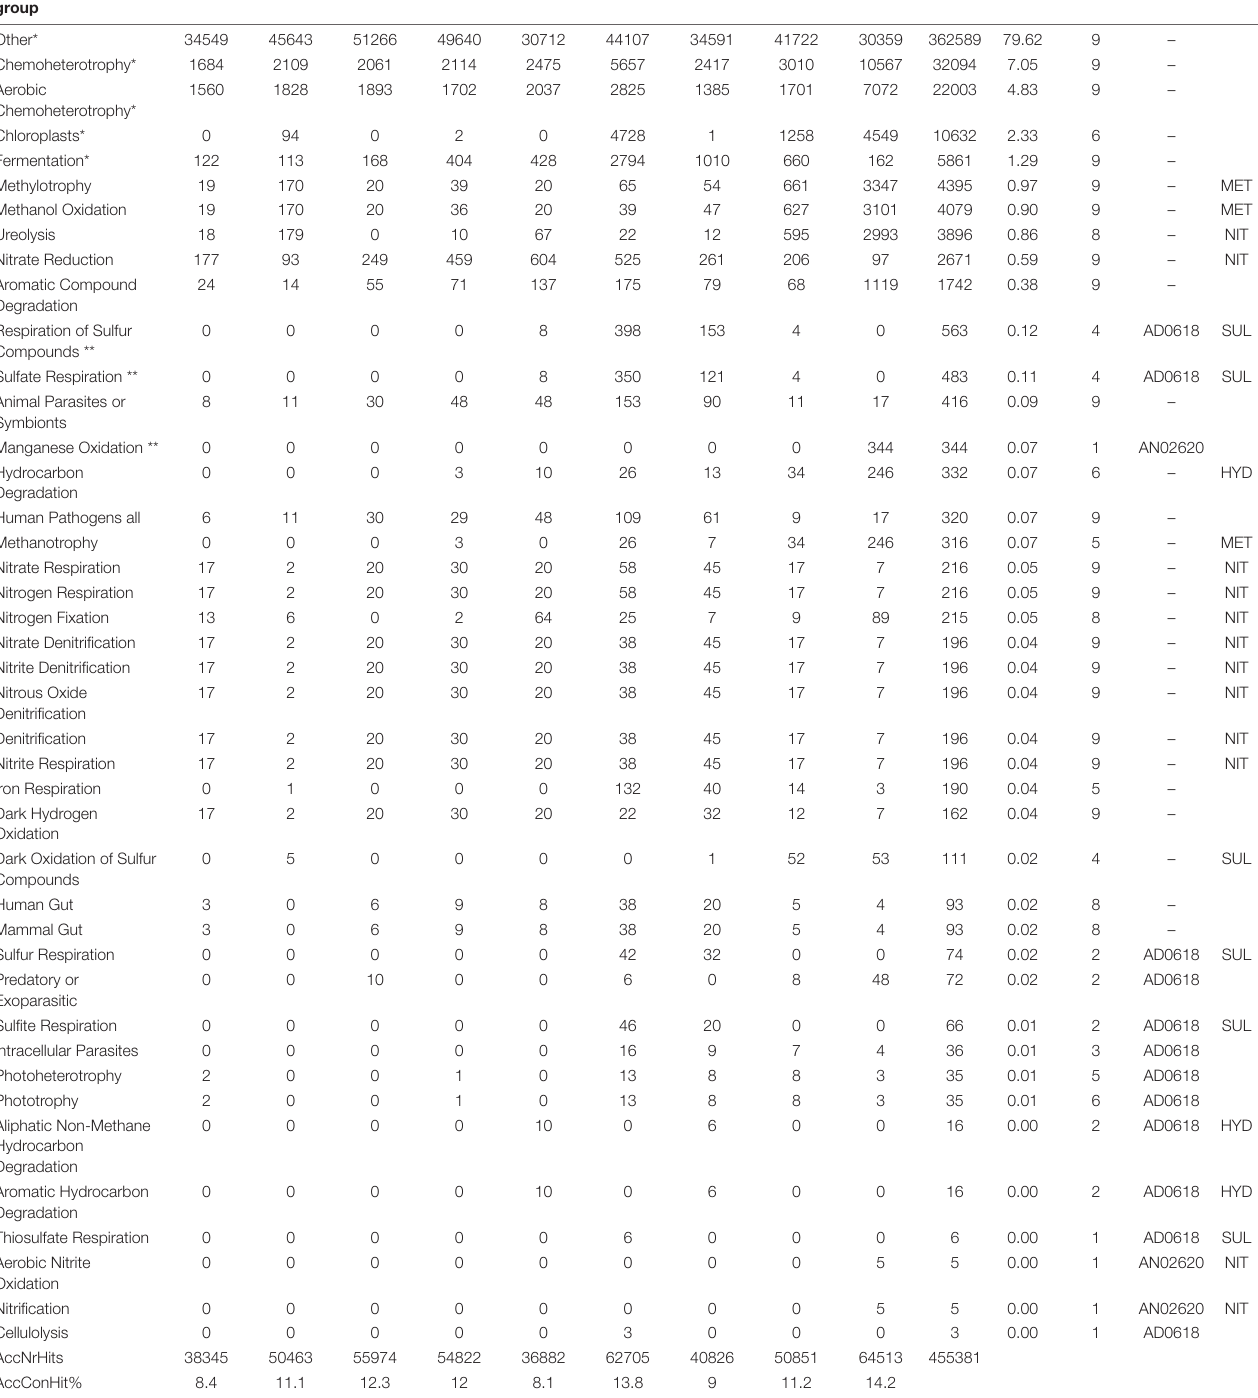
TABLE 5 | Summary of the FAPROTAX-based inference of functional differentiation. FAPROTAX functional